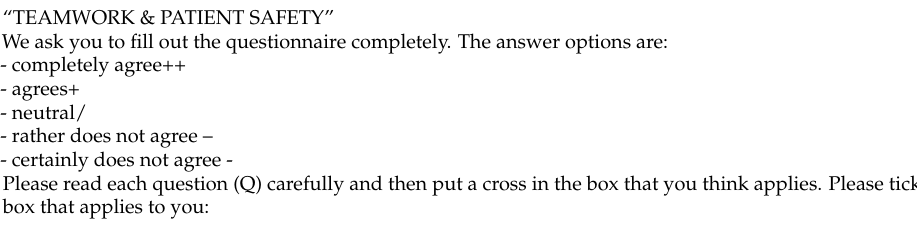
Table 1. Modified